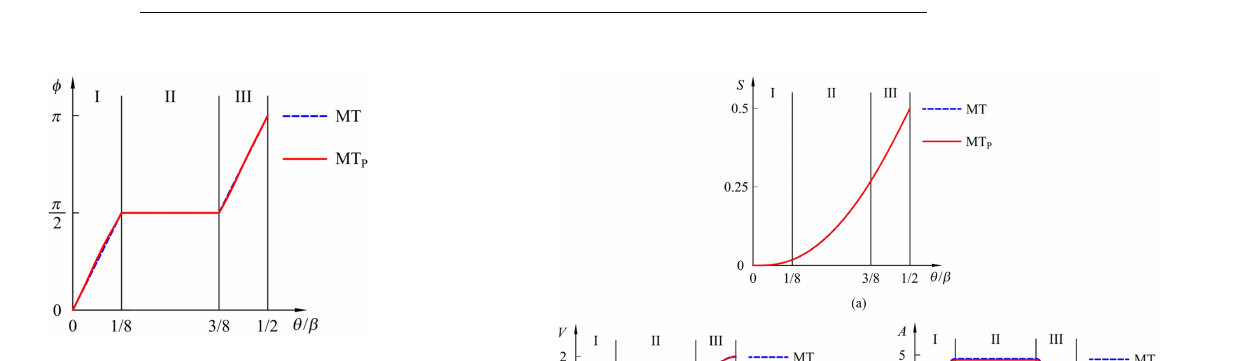
Figure 8. Variation in phase angle function in Example 3.